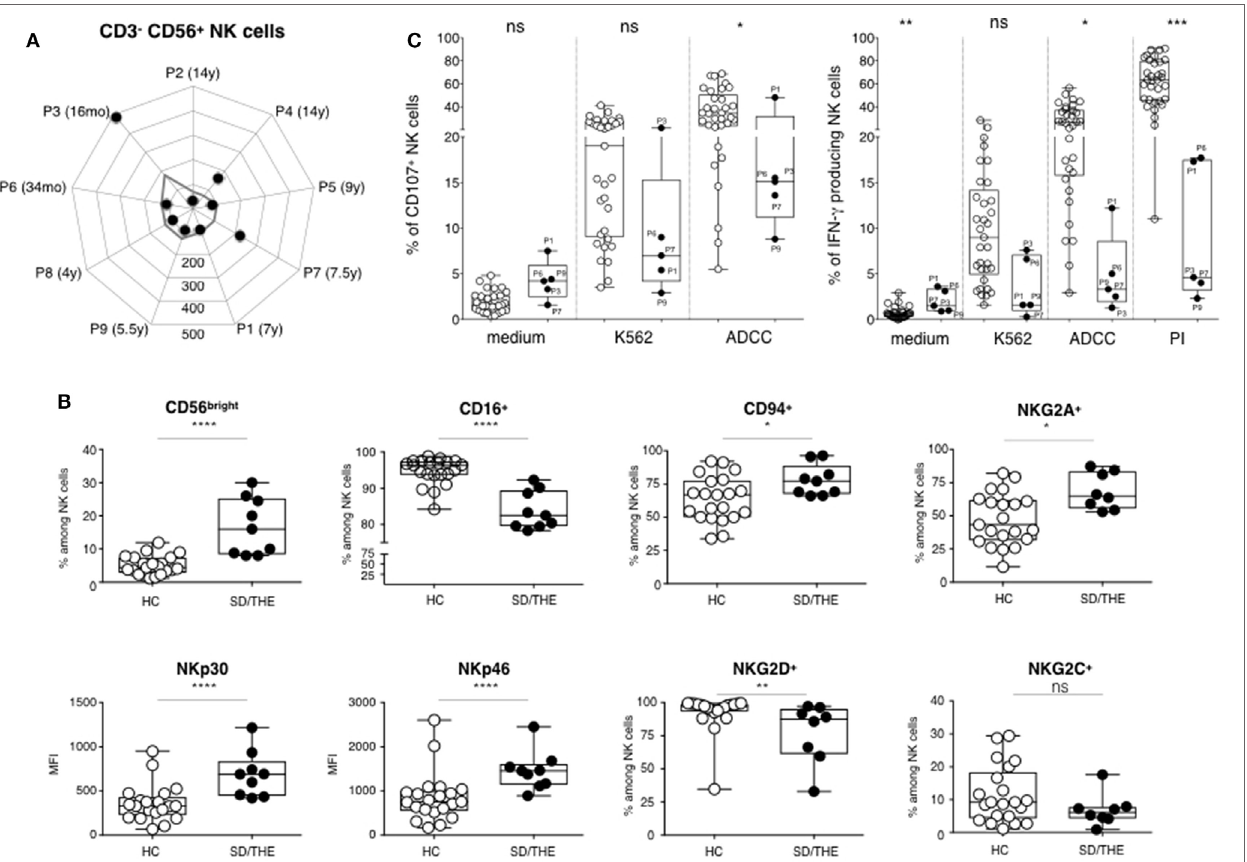
FIgURe 2 | Phenotypic and functional analysis of NK cells. (a) Absolute numbers of CD3 − CD56 + NK cells (cells per μ l). (B) Cell surface expression of the indicated molecules on NK cells among the peripheral blood lymphocytes from healthy controls HC (closed circles) and syndromic diarrhea/trichohepatoenteric syndrome (SD/THE) patients (open circles), given as a percentage of total NK cells or as median fluorescence intensity (MFI). (C) NK cell functions evaluated by their ability to release granules and to express CD107 at the cell surface (left panel) and to produce interferon gamma (right panel) after target cell contact or PMA/ionomycin (PI) activation as previously described (9). Healthy controls ( n = 33) and patients ( n = 5) are indicated as open circles and closed circles, respectively. Box-plot with medians, 25th–75th percentiles, and min–max values are shown. ns, not significant, p > 0.05; * p < 0.05; ** p < 0.01; *** p < 0.001; *** p < 0.001; *** p < 0.001 (Mann–Whitney